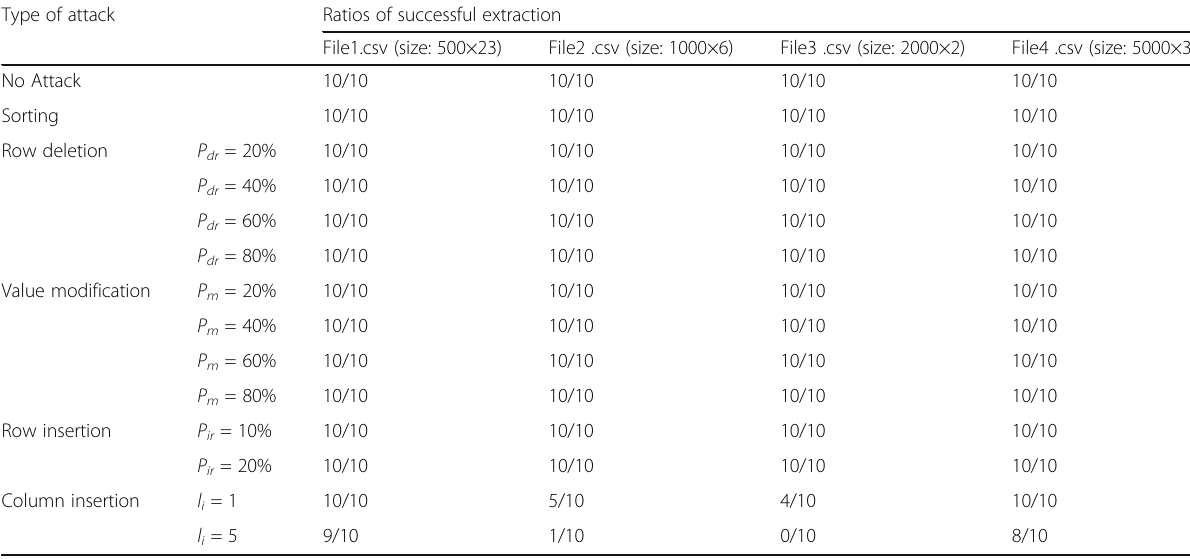
Table 4 Ratios of successful extraction under different attacks for sheets Type of